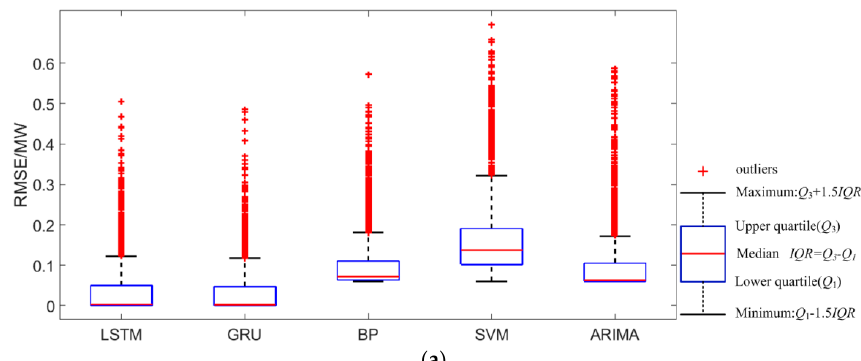
Figure 7. The mean absolute error (MAE) of photovoltaic power in different step